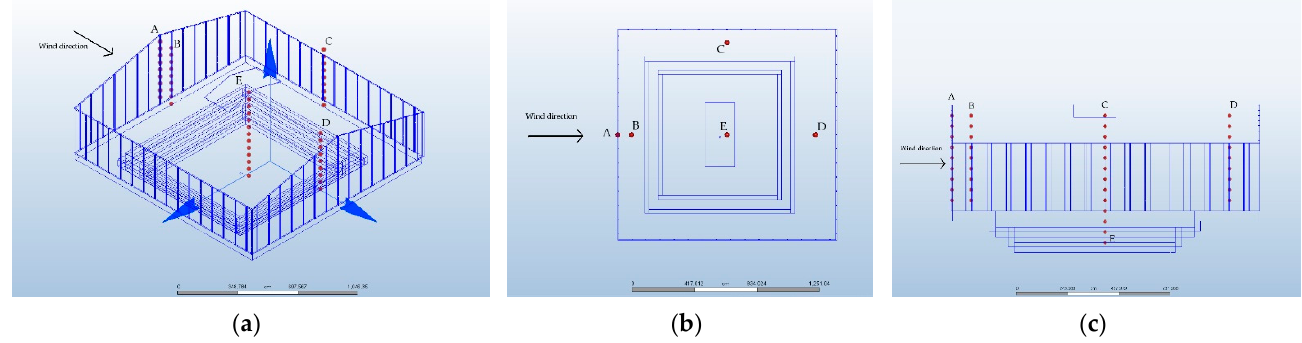
Figure 7. ( a ) Axonometry, screenshot showing the location of the five points analyzed (Autodesk CFD ® ); ( b ) Floorplan of the same model (Autodesk CFD ® ); ( c ) Section of the same model (Autodesk CFD ® ).